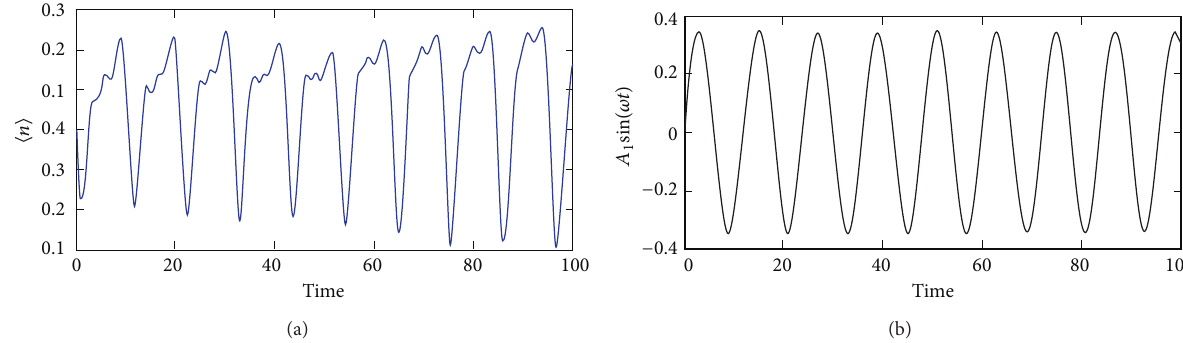
Figure 6: The 1:1 frequency-locking oscillation with the values of the parameters 𝐴 1 = 0.35 , 𝜔 = 𝜋/6 , 𝜀 = 0.11 , and 𝜏 = 3 . (a) The mean concentration of vegetation; (b) periodic forces.